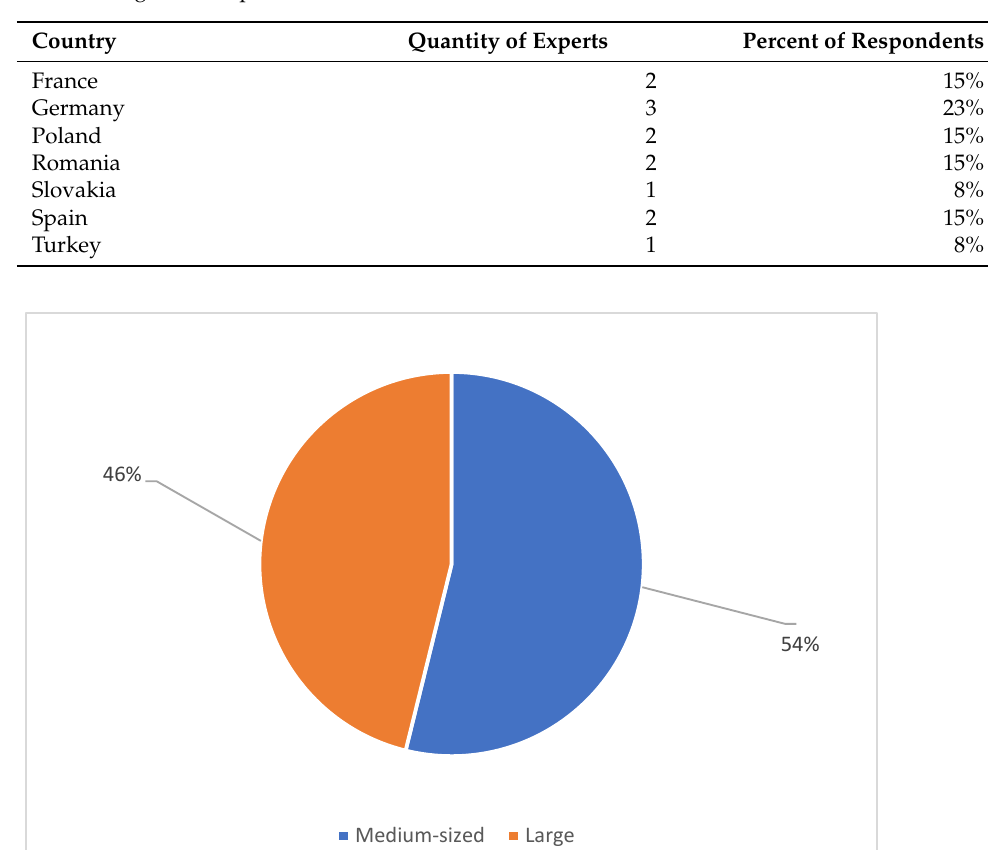
Table 3. Origin of companies.